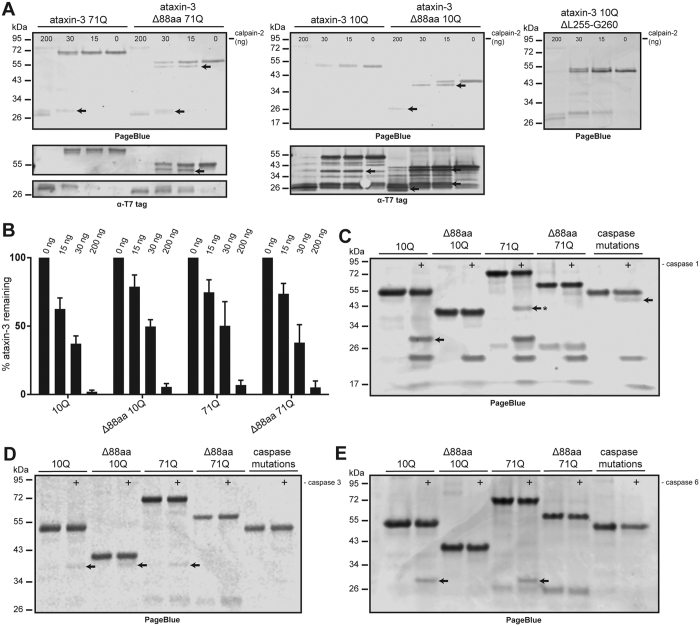
Modified ataxin-3 is cleaved less efficient by several caspases.(A) Formation of smaller ataxin-3 protein fragments are observed with increasing doses of calpain-2. Wild-type (10Q) and mutant (71Q) ataxin-3 were used either unmodified or lacking the targeted 88-amino acid region (Δ88aa). Ataxin-3 with a deletion of the previously identified calpain cleavage site (ΔL255-G260) was used as a control protein. There is a rapid decrease in full length protein and appearance of shorter protein fragments with increasing concentrations of calpain-2. After calpain-2 incubation, ataxin-3 Δ88aa with 10 and 71Q gives rise to a ~4 kDa smaller N-terminal fragment with PageBlue staining that is not observed for the wild-type protein. All fragments identified with Page Blue were positive when stained with an antibody against the N-terminal T7 tag (lower panels). Ataxin-3 ΔL255-G260 was cleaved similar to wild-type ataxin-3. (B) Quantification of uncleaved band intensity from (A) using Odyssey software. No significant differences were observed between rate of cleavage of ataxin-3 Δ88aa and the full length ataxin-3 protein variants. (C) Caspase-1 mediated cleavage of ataxin-3 resulted in a similar ~30 kDa N-terminal fragment for 10Q and 71Q ataxin-3 as indicated with the arrow. The corresponding C-terminal polyQ containing fragment (indicated with asterix) was detectable for ataxin-3 71Q. Upon removal of the 88aa neither cleavage fragment was observed for both 10Q and 71Q proteins, indicating the responsible caspases cleavage site is located in the targeted 88aa region. Bars depict mean and SE. (D) Overnight incubation with caspase-3 results in the appearance of a faint fragment of similar size for unmodified ataxin-3 10Q and 71Q, but also the proteins lacking 88aa. (E) Fragments of similar size for ataxin-3 10Q and 71Q were observed after incubation with caspase-6. Removal of 88aa prevented formation of this fragment, similar to ataxin-3 where the caspase cleavage sites were individually mutated.